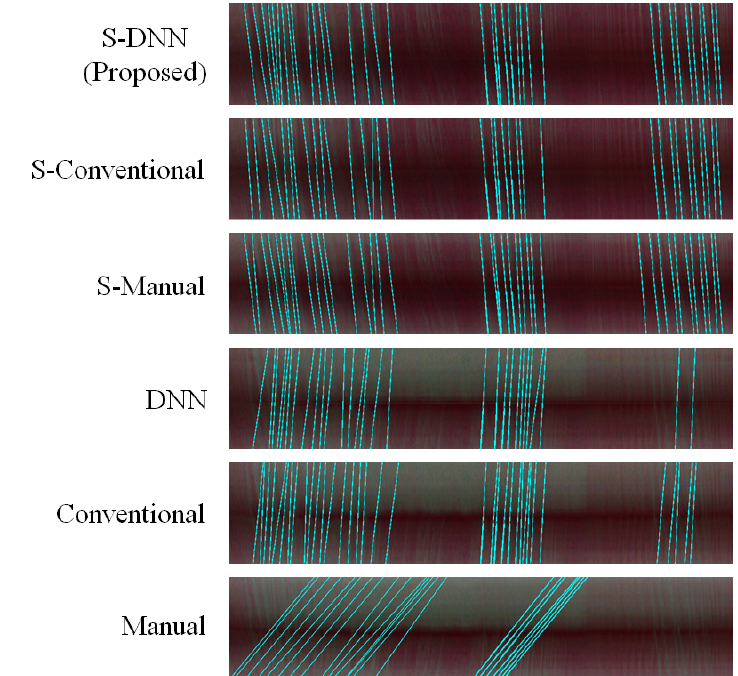
Figure A1. Events reconstructed from event counting using various methods for capillary 1.